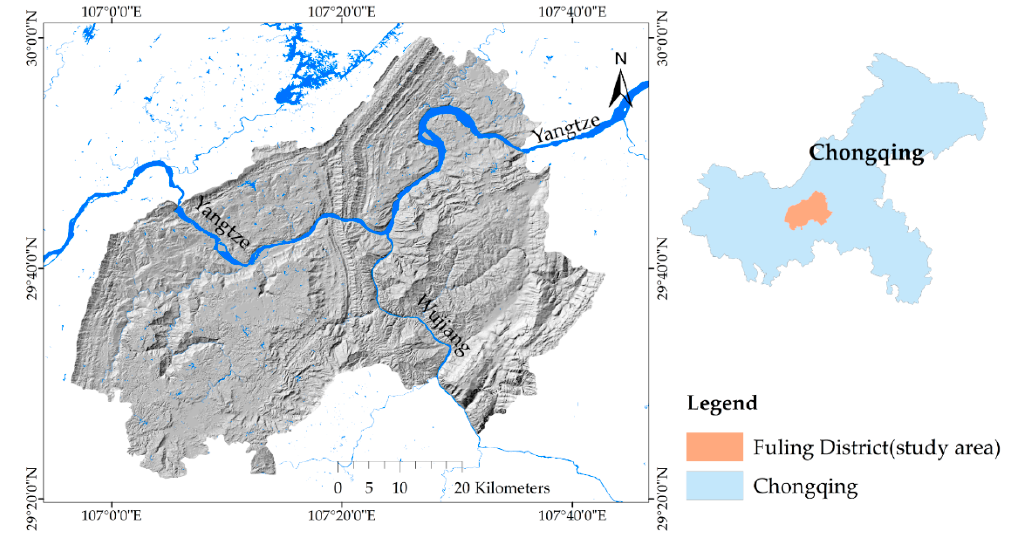
Figure 1. Study Figure 1. Study area.